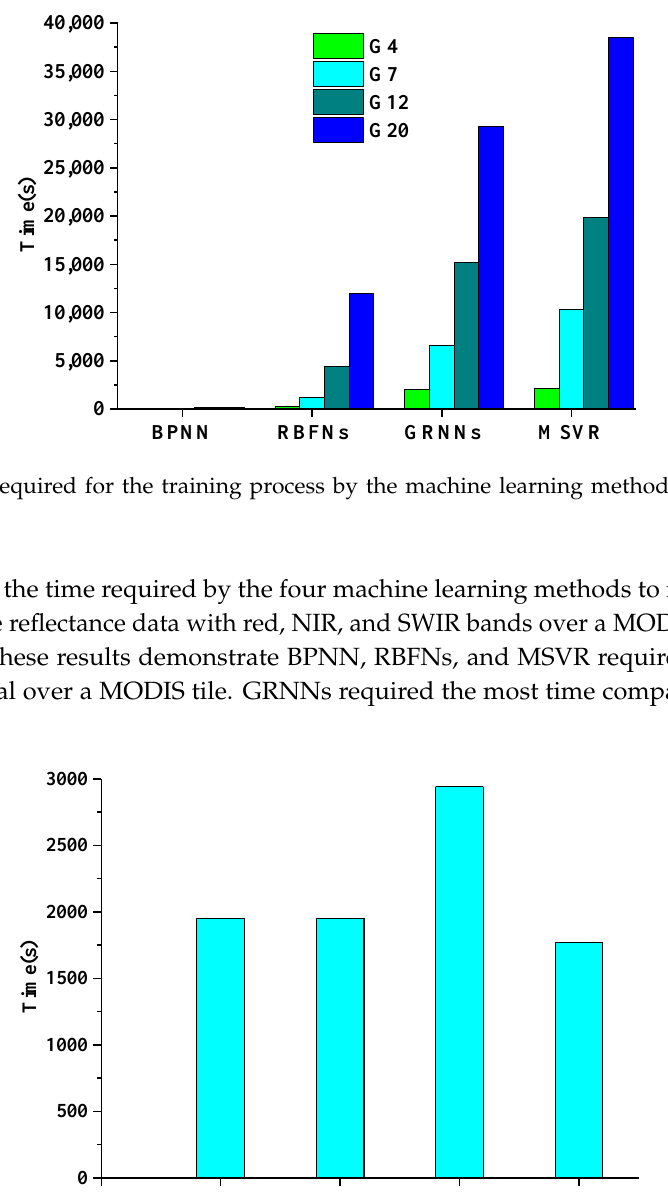
11 of 15 Figure 4. Scatter density plots of four machine learning methods between the testing LAI values and the LAI values retrieved from MODIS surface reflectance data in different band combinations and NDVI values. 3.3. Comparisons of Computational Efficiency Computational efficiency is an important evaluation metric for operational algorithms to